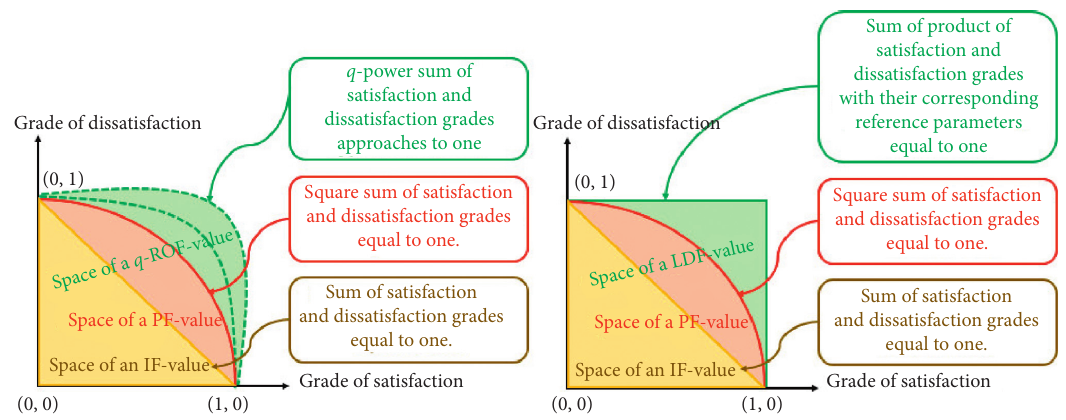
Figure 1: Comparison view of IFNs, PFFNs, q -ROFNs, and